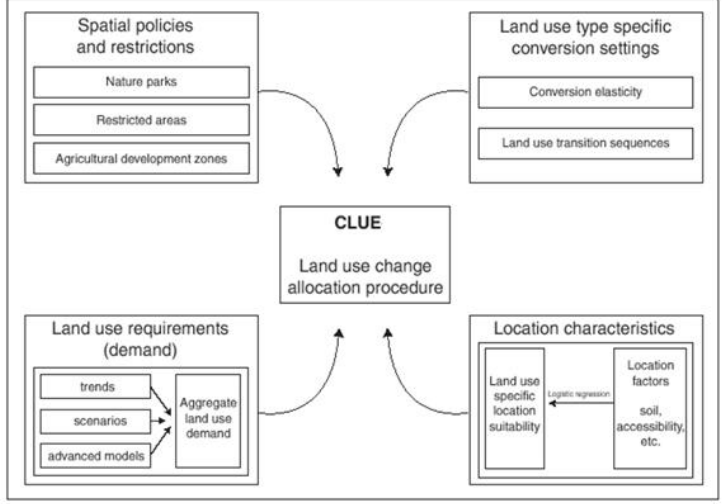
Figure 3. General view of the Dyna-CLUE model. Source: The CLUE model Hands-on Exercises Course Material (Verbug, 2010).